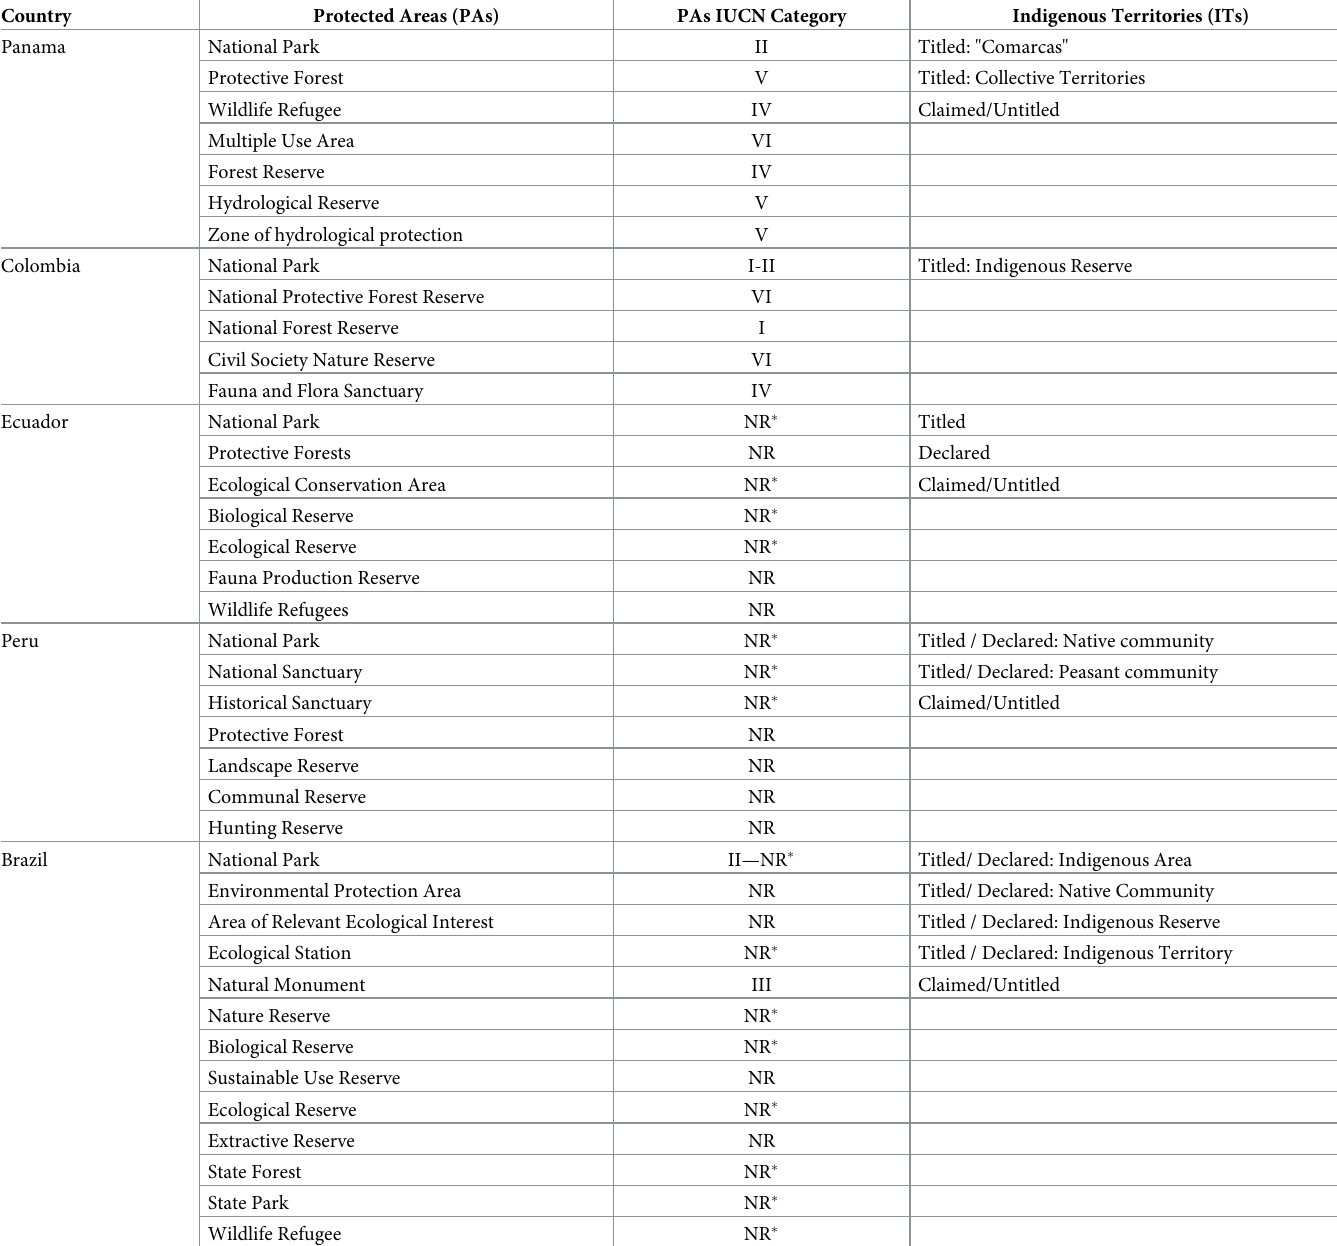
Table 1. PAs and ITs included in the study.